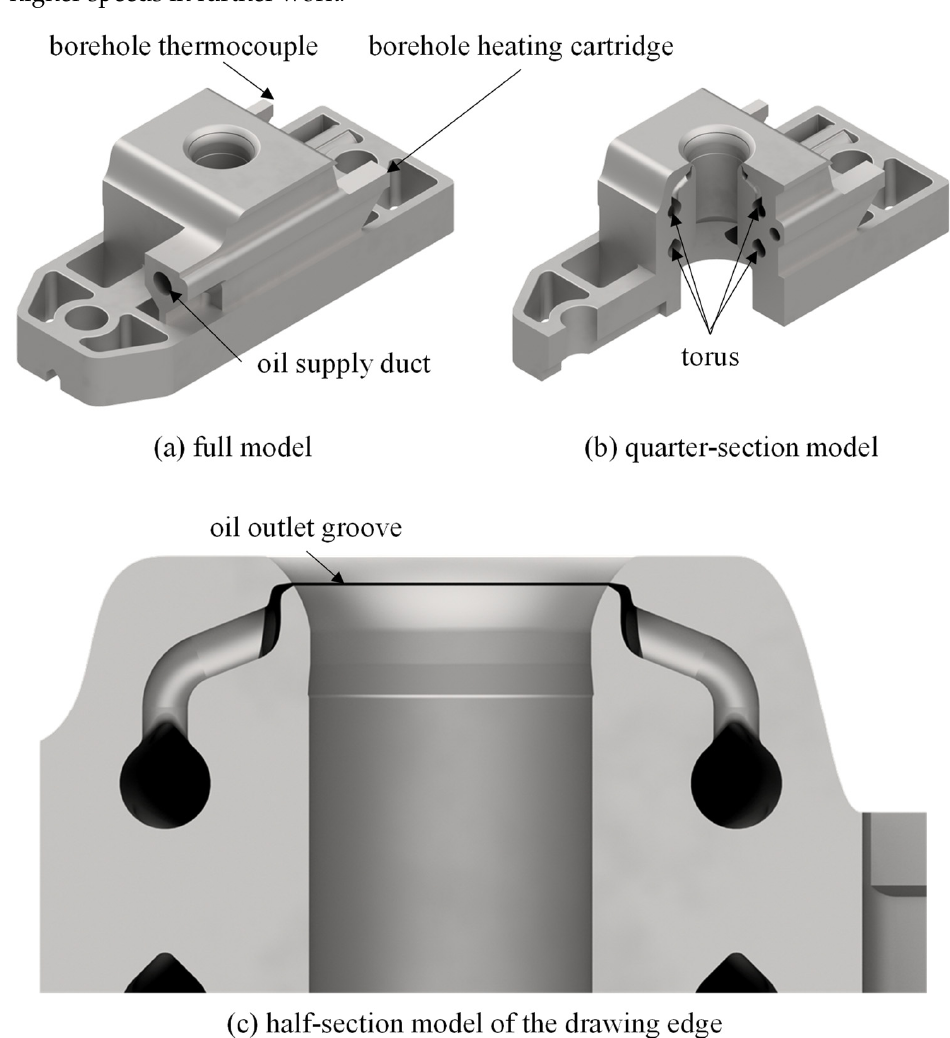
Figure 20. Design of the forming tool with process-integrated lubrication.